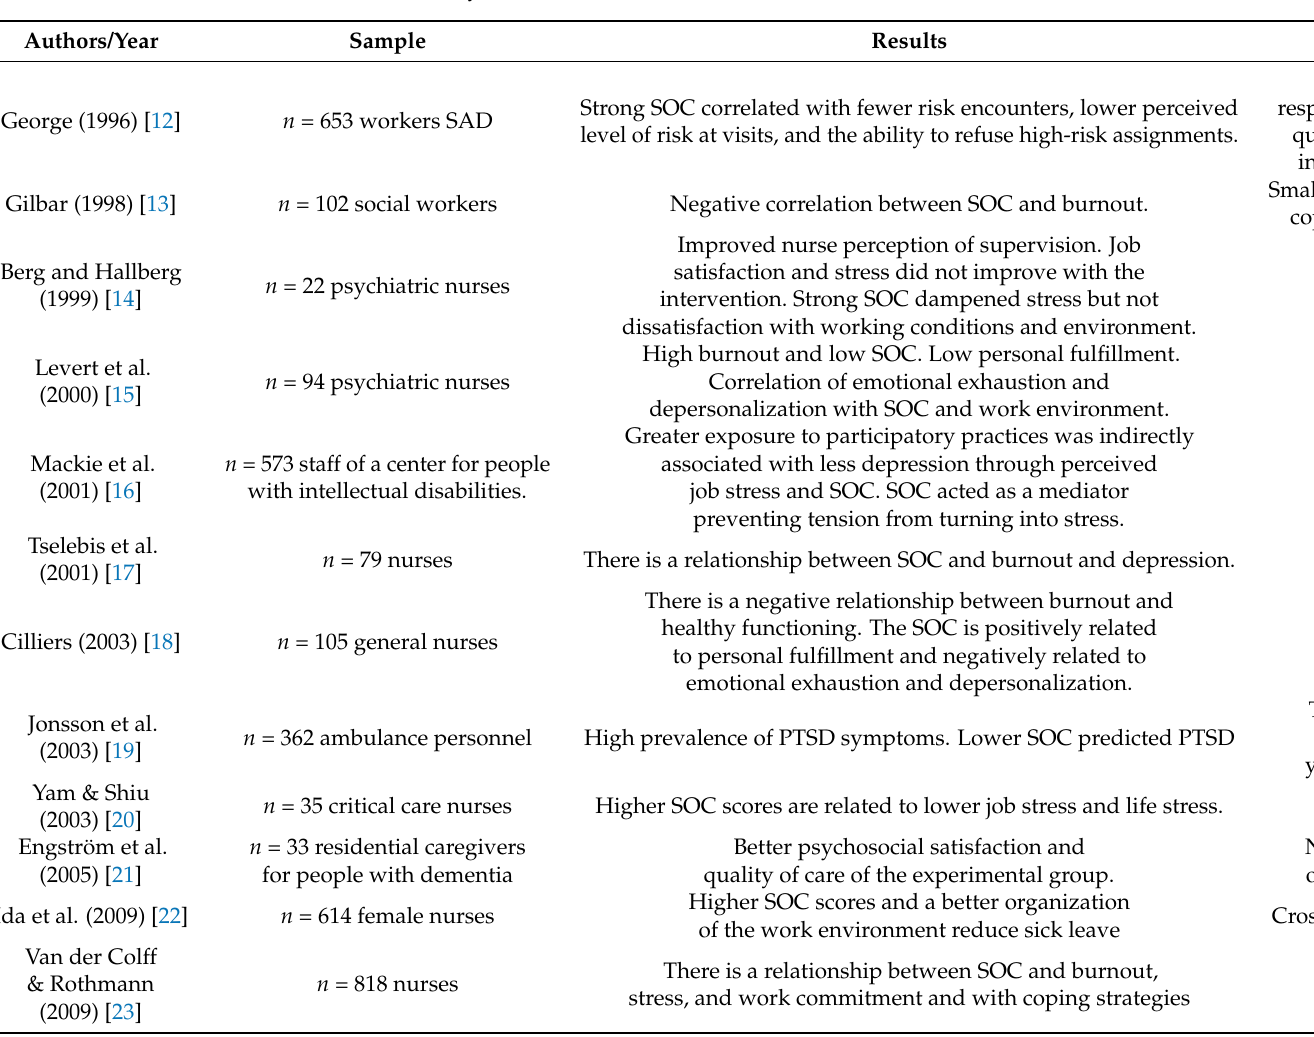
Table 1. Summary of the reviewed